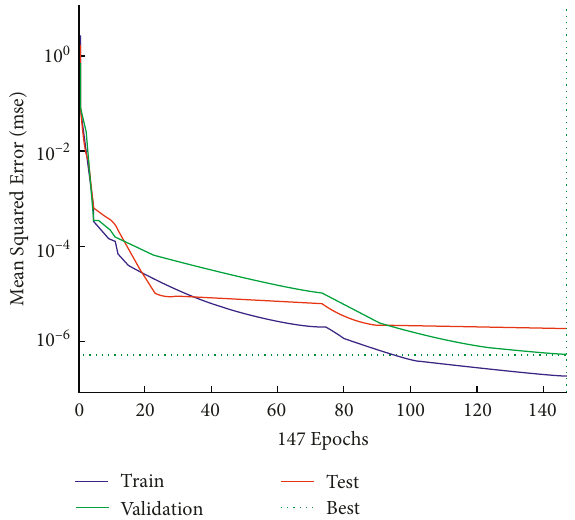
Figure 12: Training curve of the BP neural